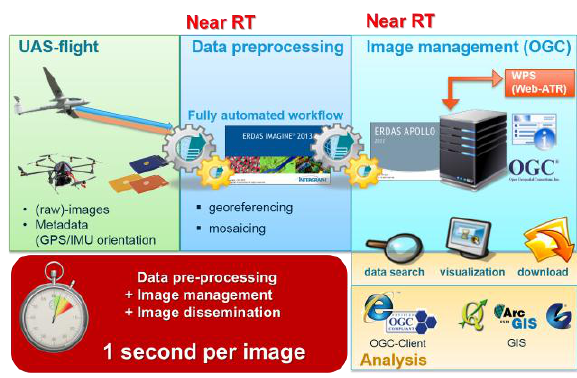
Figure 4: Automated workflow for data pre-processing to data dissemination